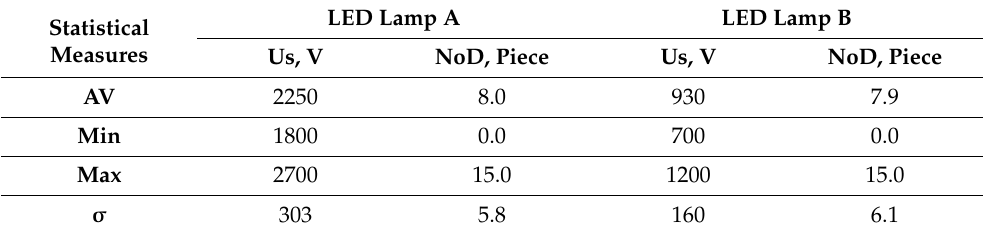
Table 4. Results of statistical analysis for LED lamps of A and B types.